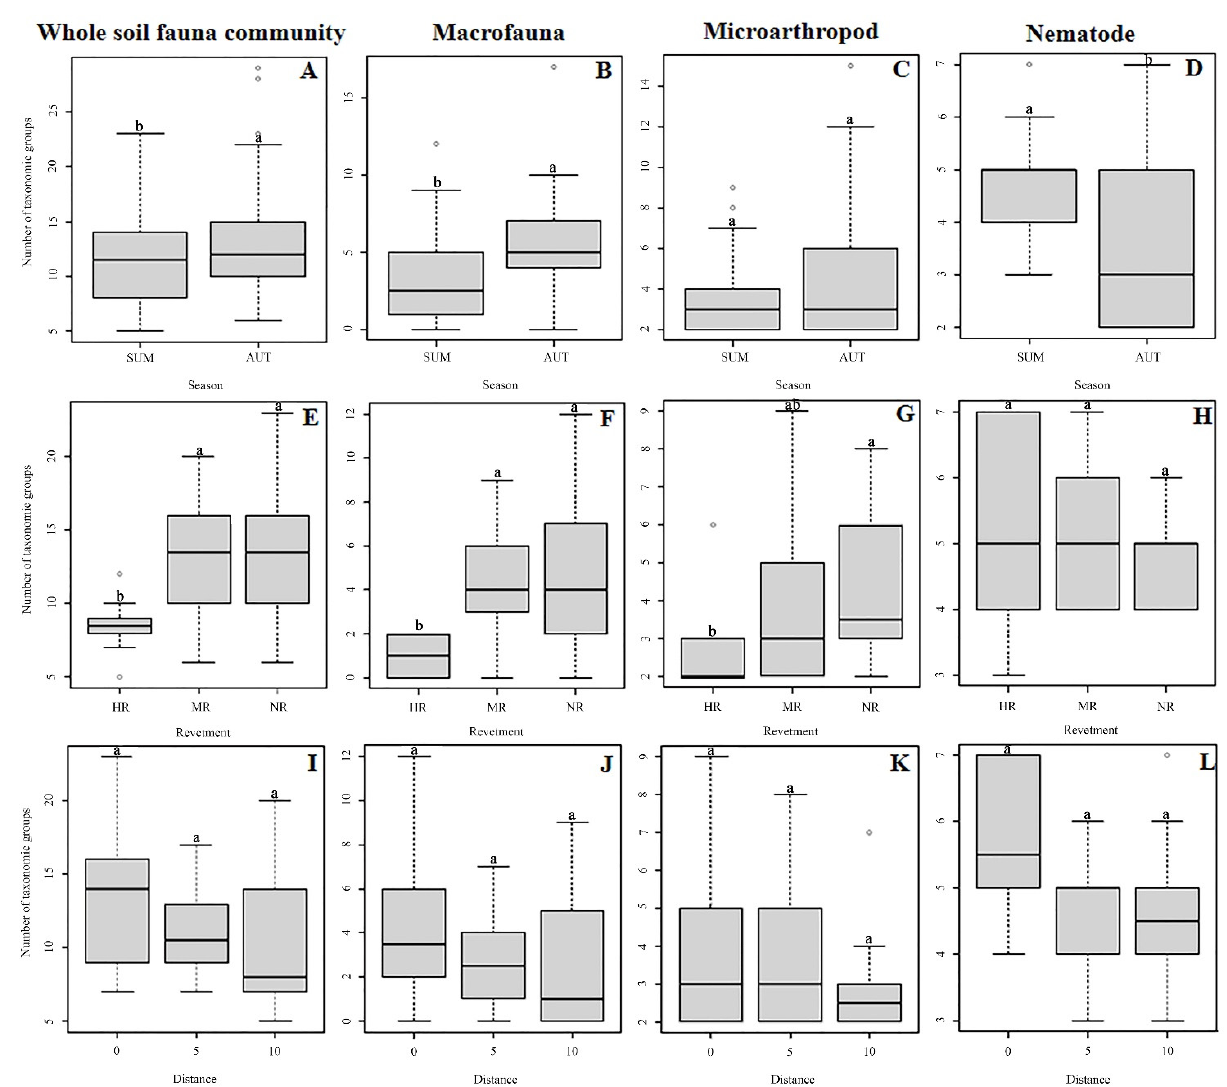
Figure 3. Richness of soil animal groups in two seasons ( A – D ) and richness of soil animal groups of three revetment types ( E – H ) and three distances ( I – L ) in summer. Taxonomic group number is the number of families, except insect larvae, which were at the order level. Each box plot displays the median (bold lines), the interquartile range (box), minimum and maximum values (whiskers), and outliers (circles). Different lower-case letters indicate significant differences among revetment types and distances ( p < 0.05). The plots of three revetment types and distances in autumn are not presented due to non-significance.